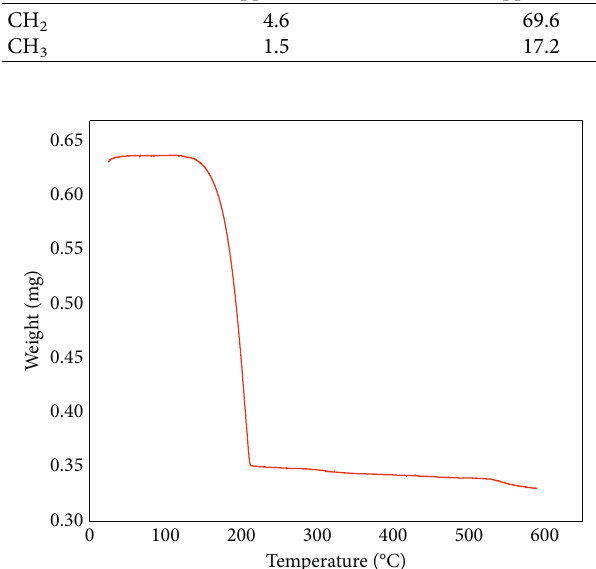
Figure 4: TGA curve of the NiEtX complex. Characterization of nickel sulfate (NiS) thin films and